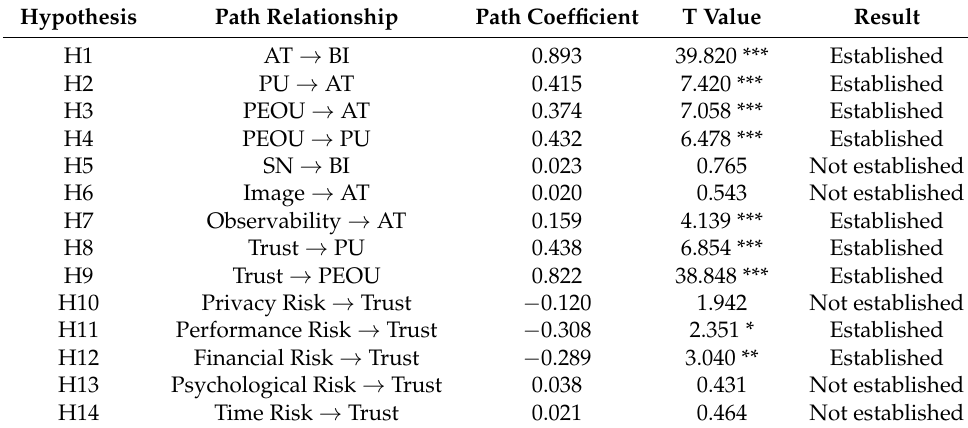
Table 3. Results of research